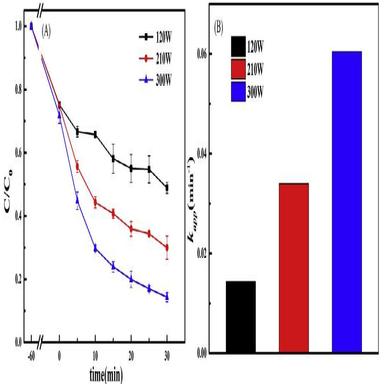
Effect of ultrasonic power on the sonocatalytic degradation of RhB (A) and the corresponding Kapp values (B).